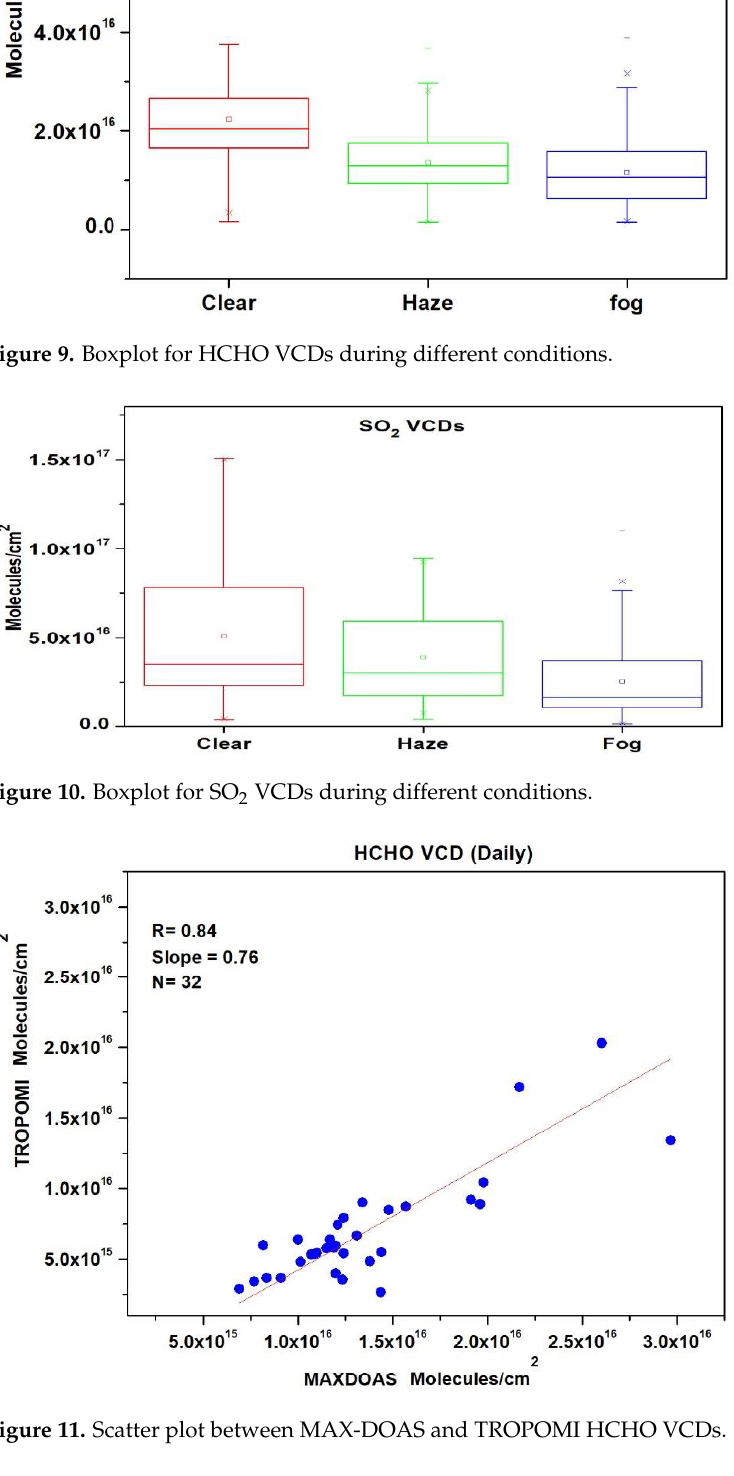
Figure 9. Boxplot for HCHO VCDs during different conditions.